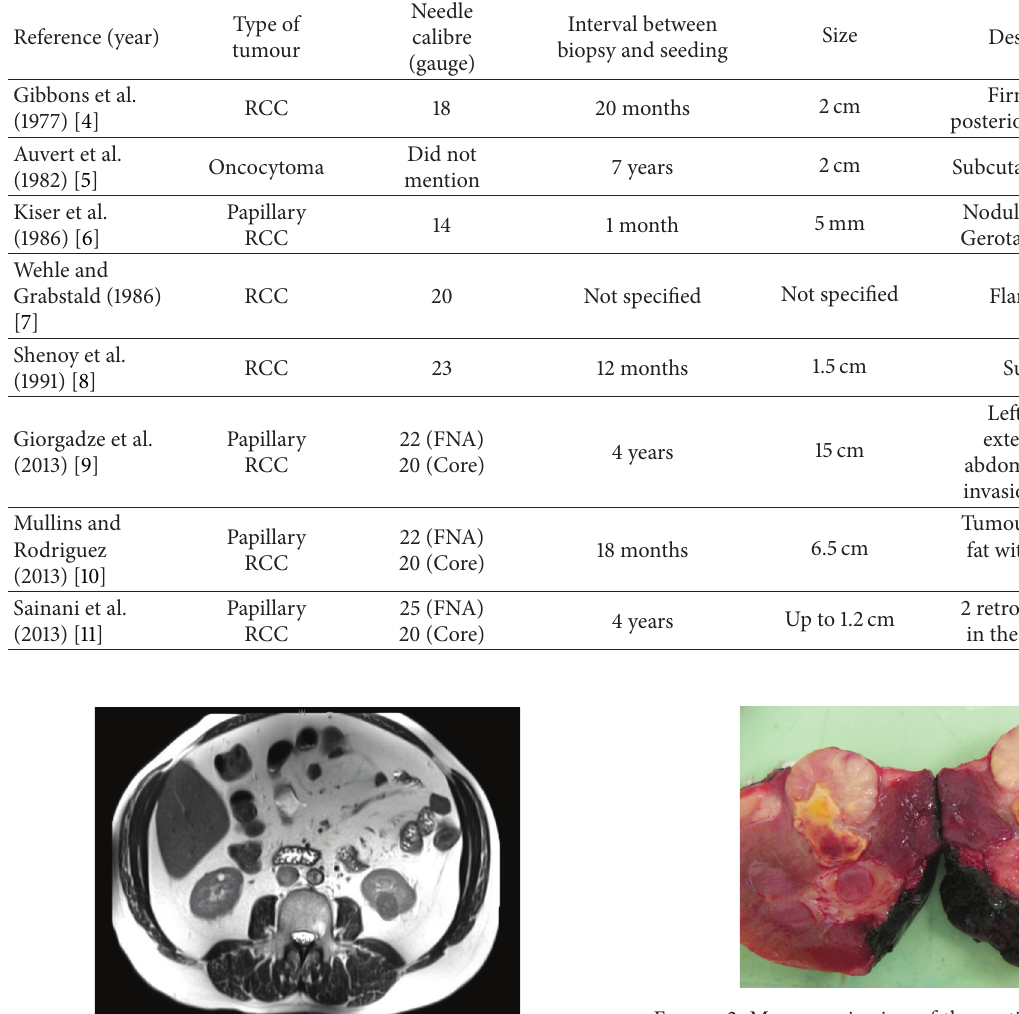
Figure 2: Macroscopic view of the partial nephrectomy specimen demonstrating a 23 × 20 mm well-demarcated